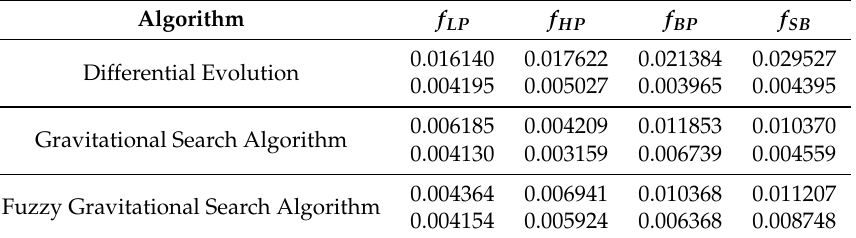
Table 8. Convergence profile results.